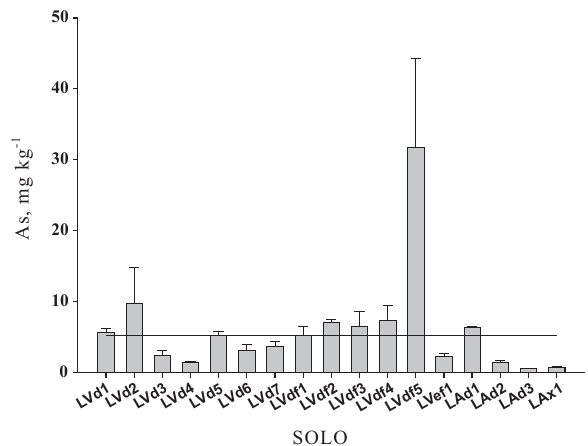
Figura 1. Teor semitotal de As nos 17 Latossolos brasileiros determinado após digestão pelo método USEPA 3051A. As barras acima das colunas indicam o desvio-padrão, e a linha, o teor médio de As dos